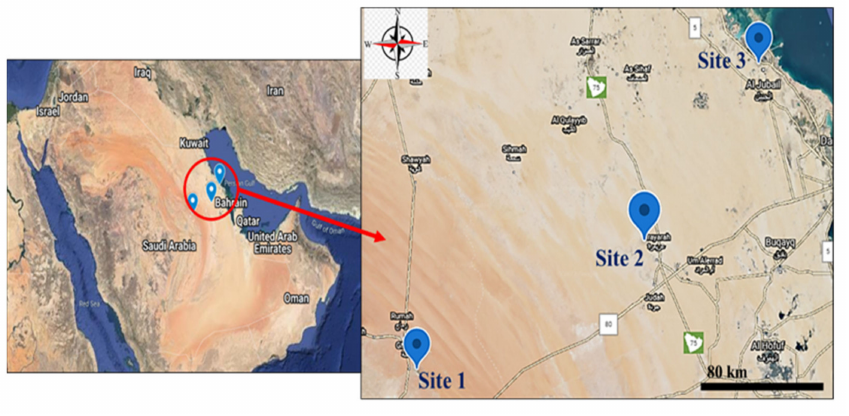
Figure 1. A map showing the sites of the